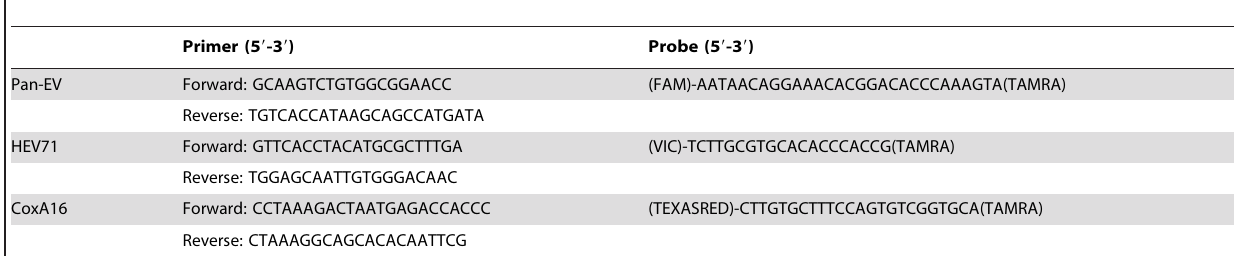
Table 1. Nucleotide sequences of the specific primers and Taq Man